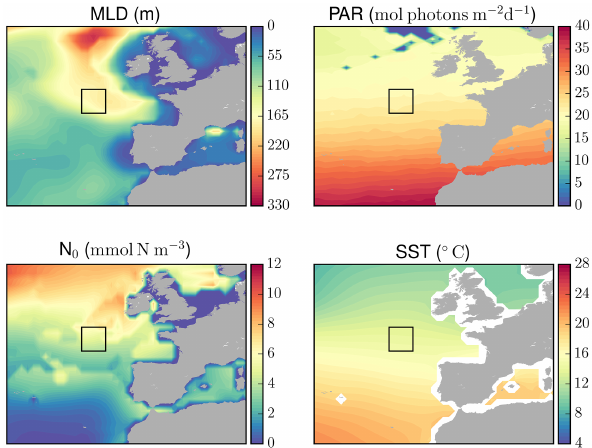
Figure 1. Environmental forcing variables considered in Phy- toSFDM. The data shown are the annual average of mixed-layer depth (MLD), photosynthetic active radiation (PAR), sea surface temperature (SST), and nitrogen concentration below the mixed layer ( N 0 ). The square boxes mark the location of the test-case sim-